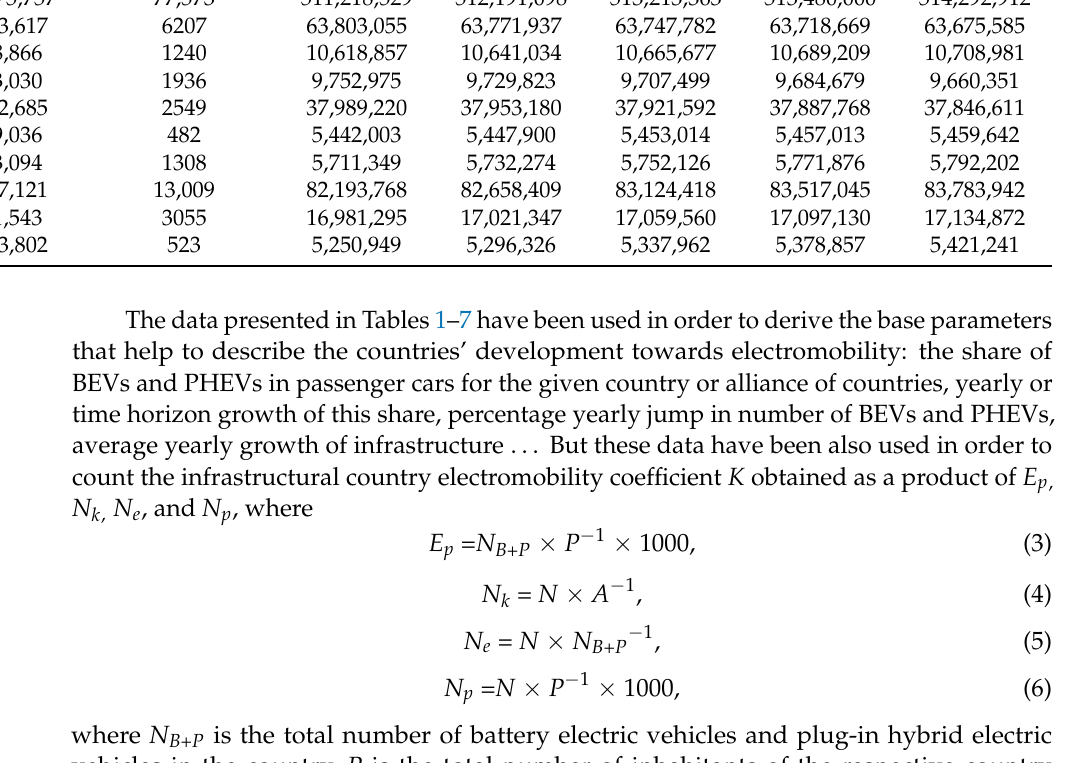
Table 7. The data on population development, area and highways length of selected countries and alliances, (source: elaborated by authors based on [25,51,55–58]). Area Highways Population of the Country at the End of the Years km × km Length in km EU (incl.